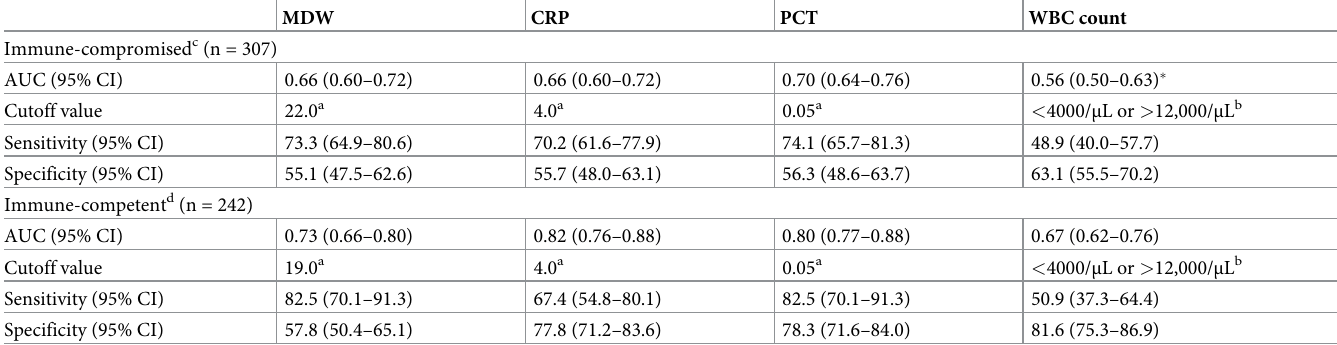
Table 4. Diagnostic performance of WBC count, CRP, PCT, and MDW for predicting sepsis according to immune